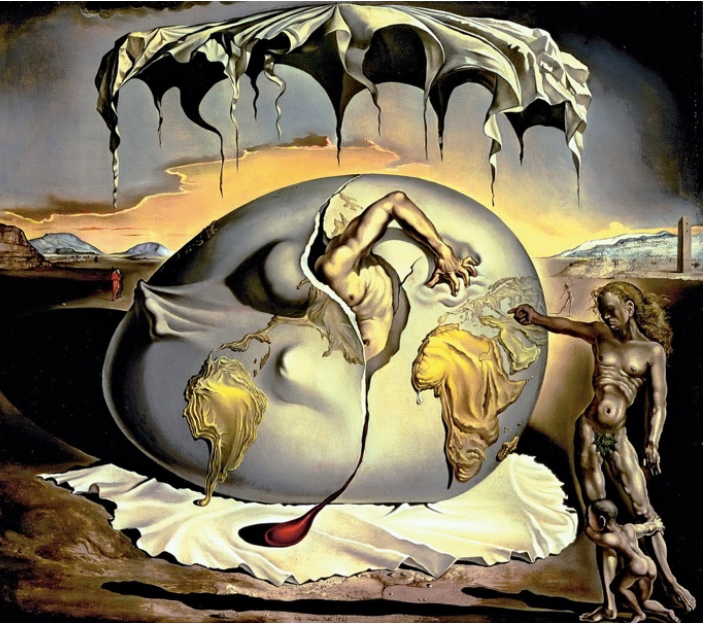
Figure 1. Salvador Dalí, Geopolitics Child Watching the Birth of the New Man, 1943. Photo by Lluisribesmateu1969, licensed under Creative Commons: CC BY-NC 2.0.